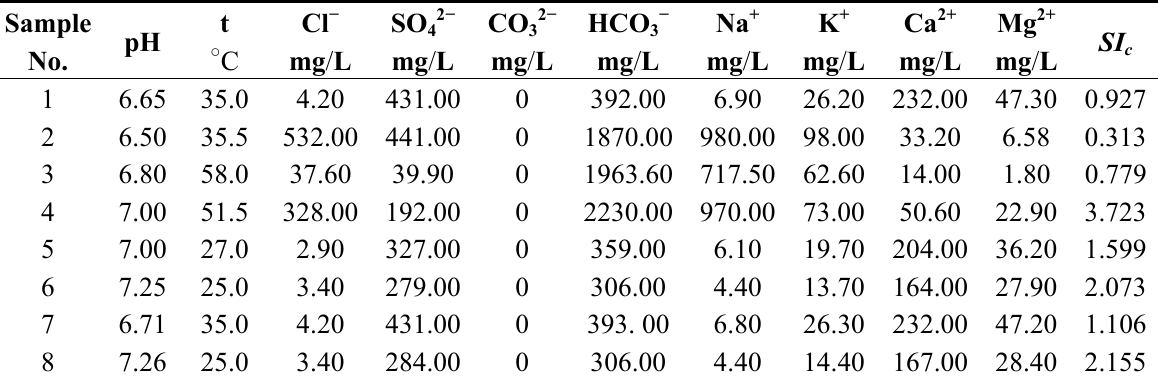
Table 1. Analysis results of water samples, including pH value, temperature (t), chloride (Cl −